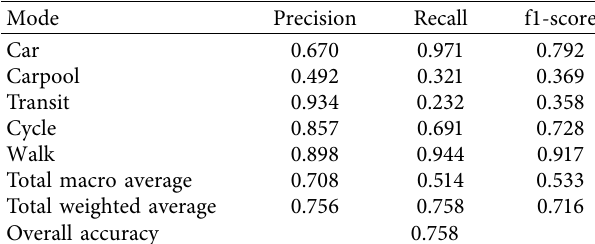
Table 6: Results modal split estimation OViN data for 6 clusters.